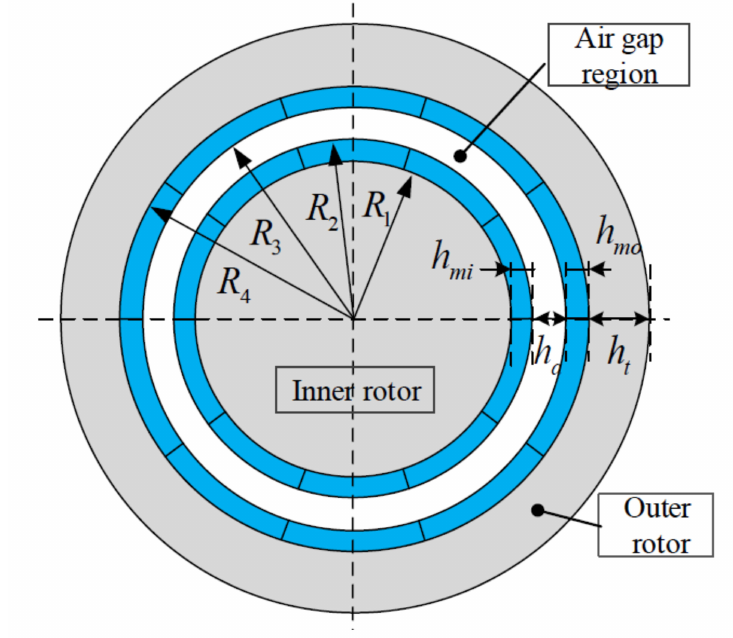
Figure 7. Two-dimensional model of cylindrical permanent magnet